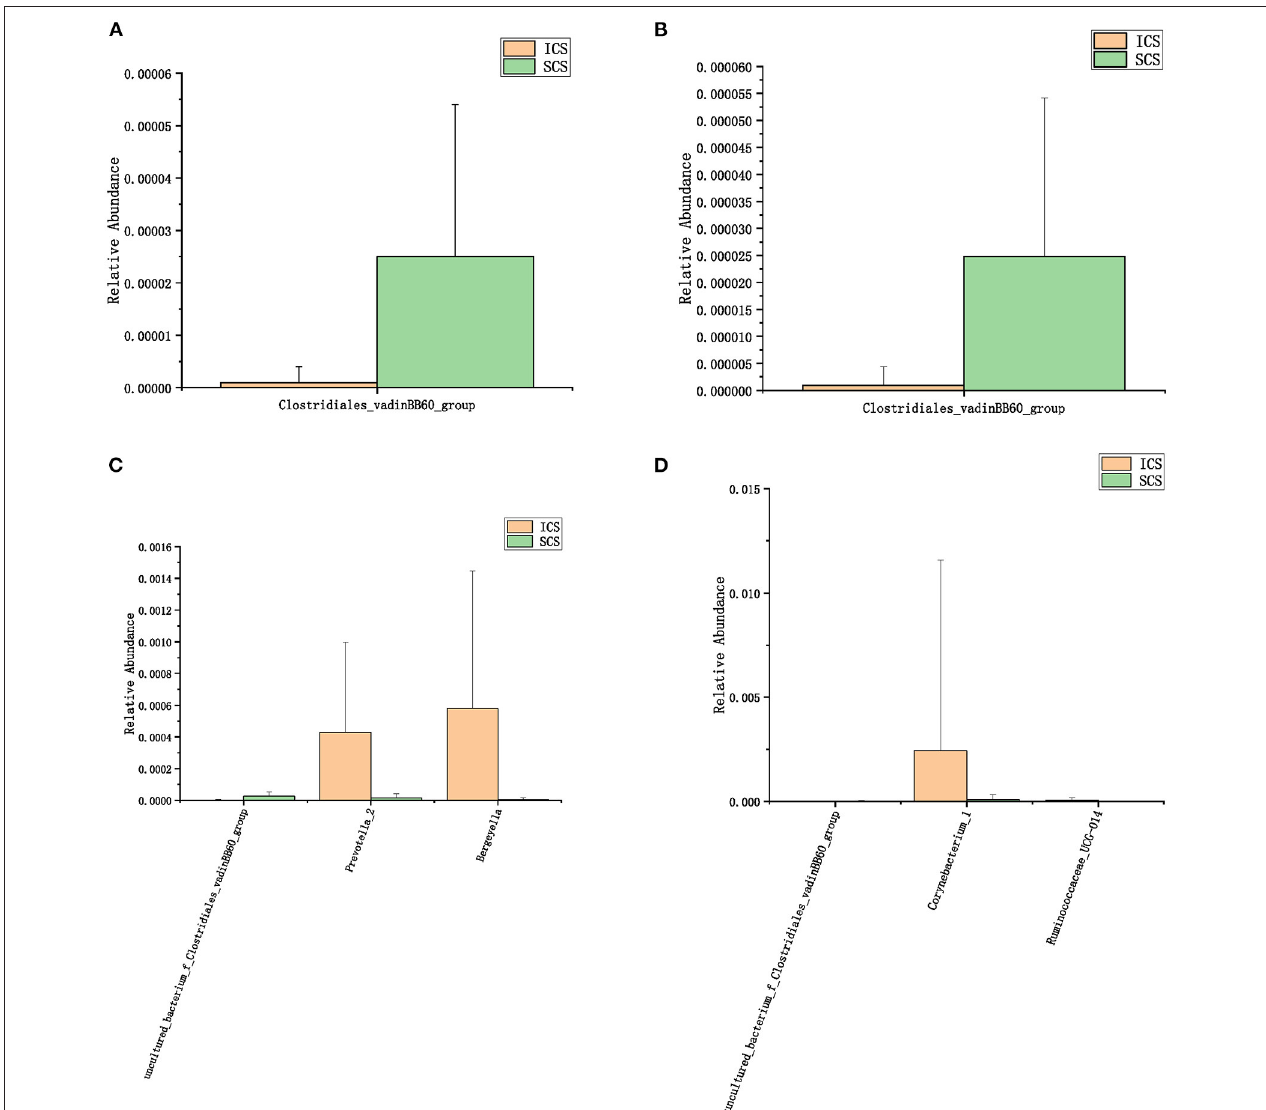
FIGURE 6 | Colonies with different abundances after 14 days of treatment. (A) : One-way analysis of variance by ANOVA at the family level. (B) : Calculated by Wilcoxon test at the family level. (C) : One-way analysis of variance (ANOVA) at the genus level. (D) : Calculated by Wilcoxon test at the genus level. ( p < 0.05).